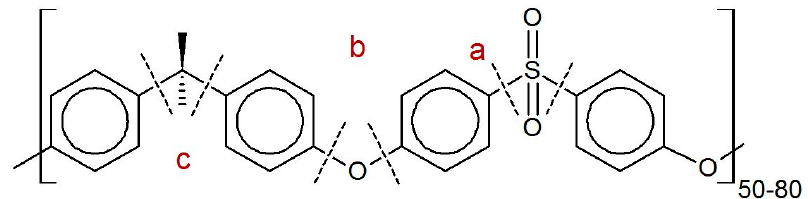
Figure 12. Possible degradation mechanisms of polysulfone given: ( a ) crosslinking by phenylation of phenyl radical formed by cleavage of C–S bond; ( b ) intramolecular phenylation by hydrogen abstraction by the phenyl radical; ( c ) β -scission of isopropylidene radical following H-abstraction [31,33,35].